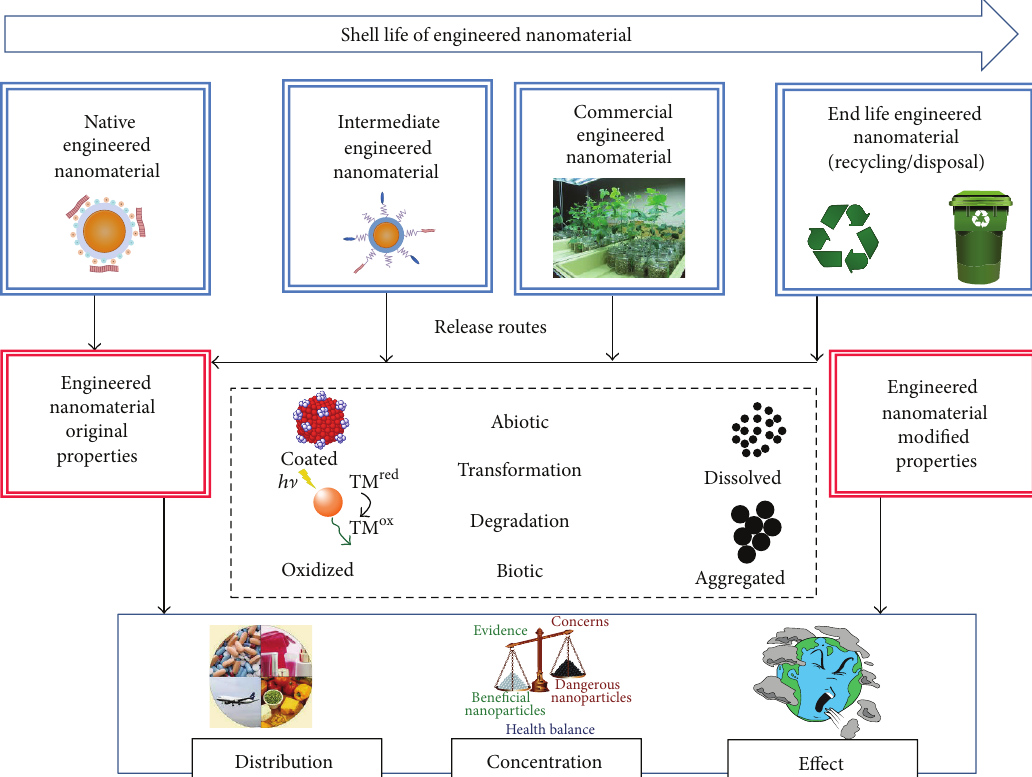
Figure 2: Release routes of engineered nanomaterials in living